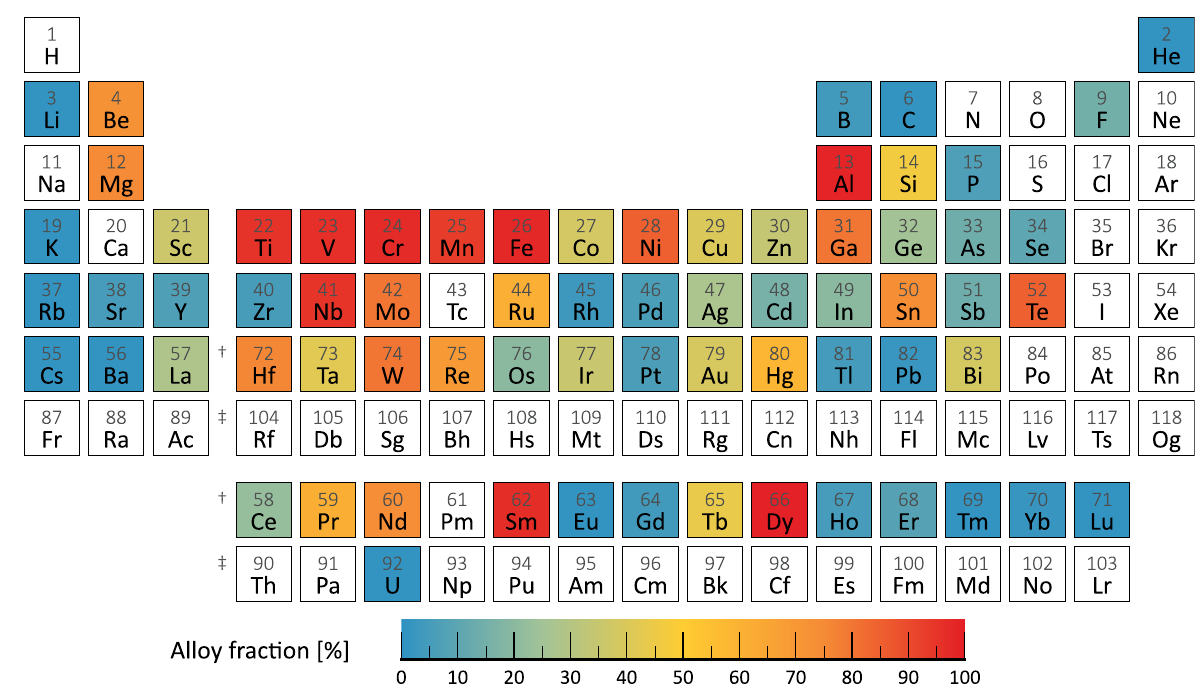
Fig. 2 Fractional use of elements in alloy form. Estimates on the alloy use per end use sector and element are provided in Supplementary Table 3.